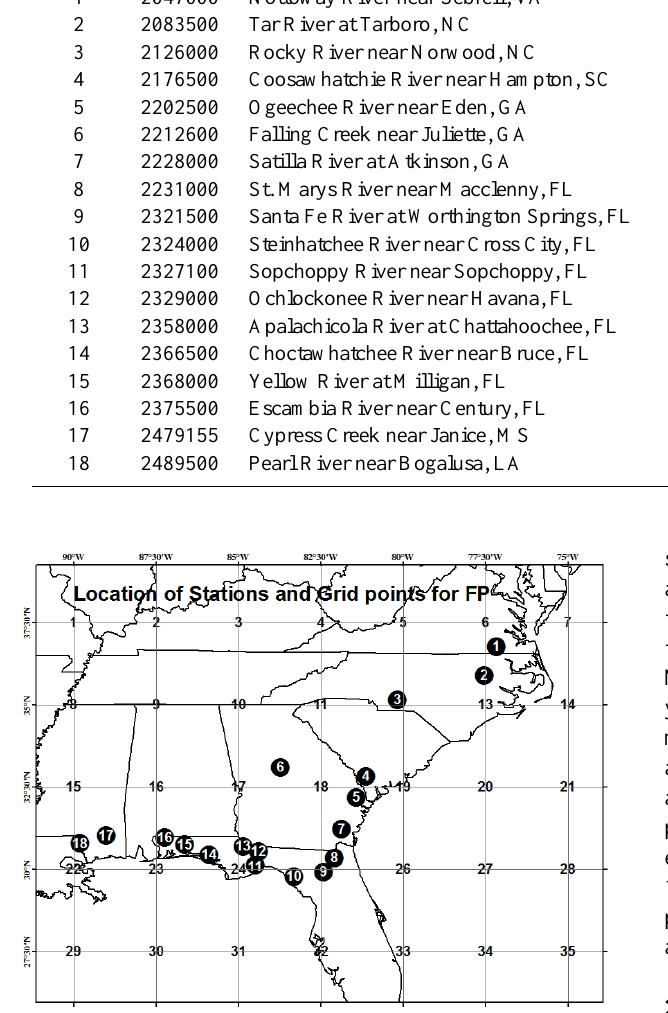
Figure 1. Locations of 18 water quality monitoring stations and grids of forecasted precipitation from NOAA’s reforecast model. 18